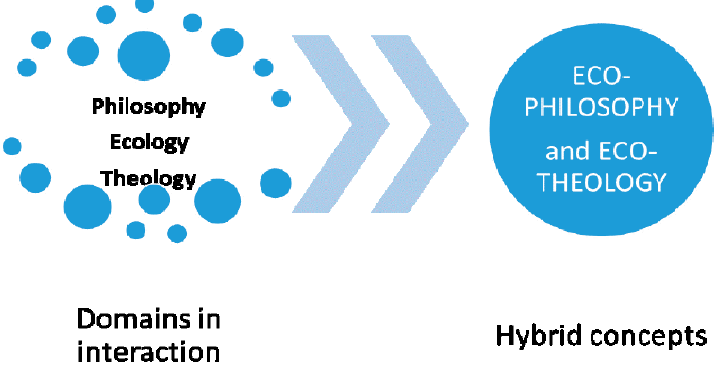
Figure 2. Interaction of three domains generates hybrid concepts .